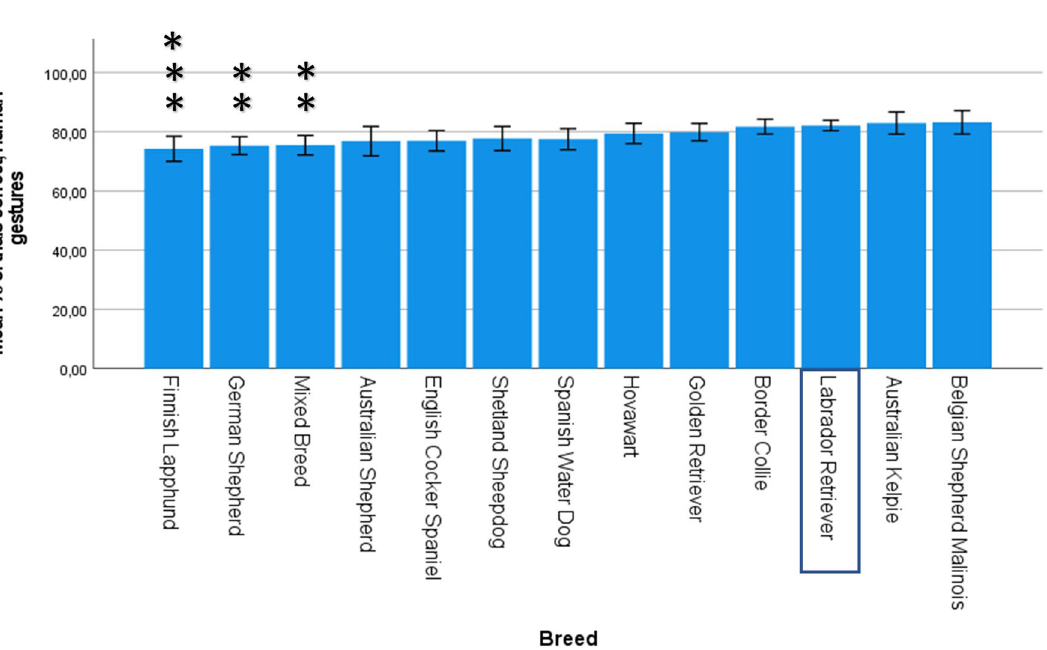
Figure 2. Mean percentage of correct trials for each breed in the cylinder test are presented, using the untransformed, original data (n = 992). Error bars represent 95% confidence intervals. Breeds are ordered based on B-values, with lowest success (low inhibitory control) on the left and highest success (high inhibitory control) on the right. The Labrador Retriever was used as the reference breed. Significant P-values (Bonferroni- corrected) are indicated with asterisks: ***p ≤ 0.001, **p ≤ 0.01, *p ≤ 0.05.